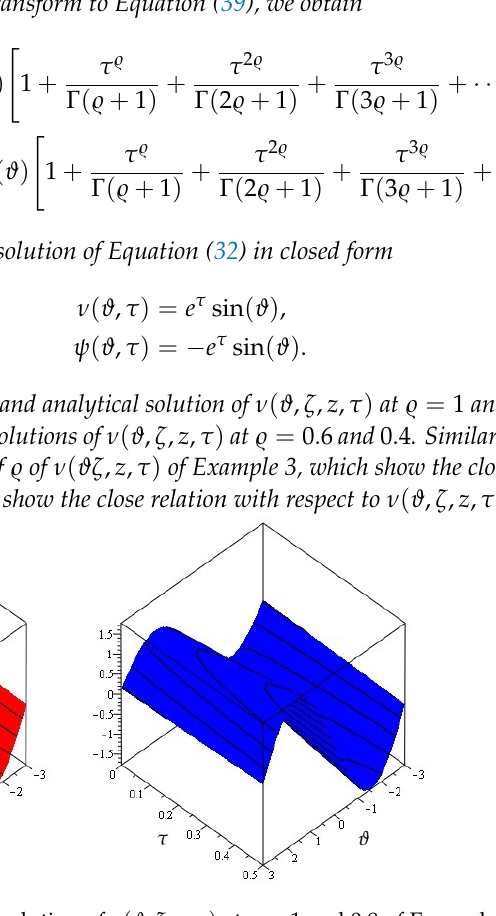
Figure 7. Exact and analytical solution of ν ( ϑ , ζ , z , τ ) at (cid:36) = 1 and 0.8 of Example 3.